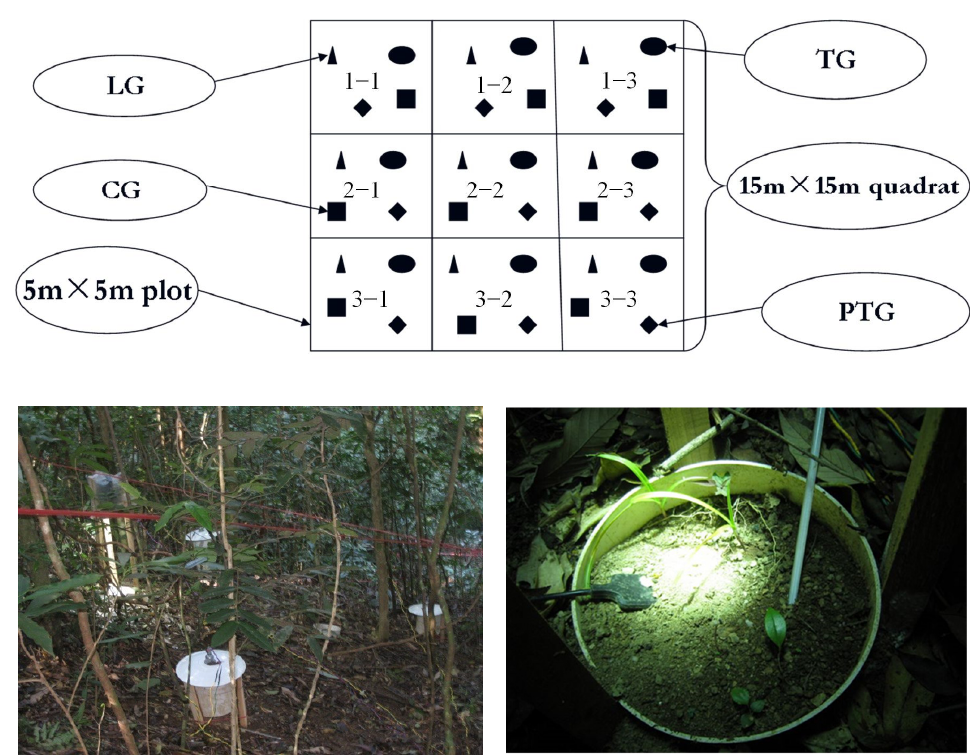
Figure 2. Plot design for the photo-thermal separation experiment in the forest.